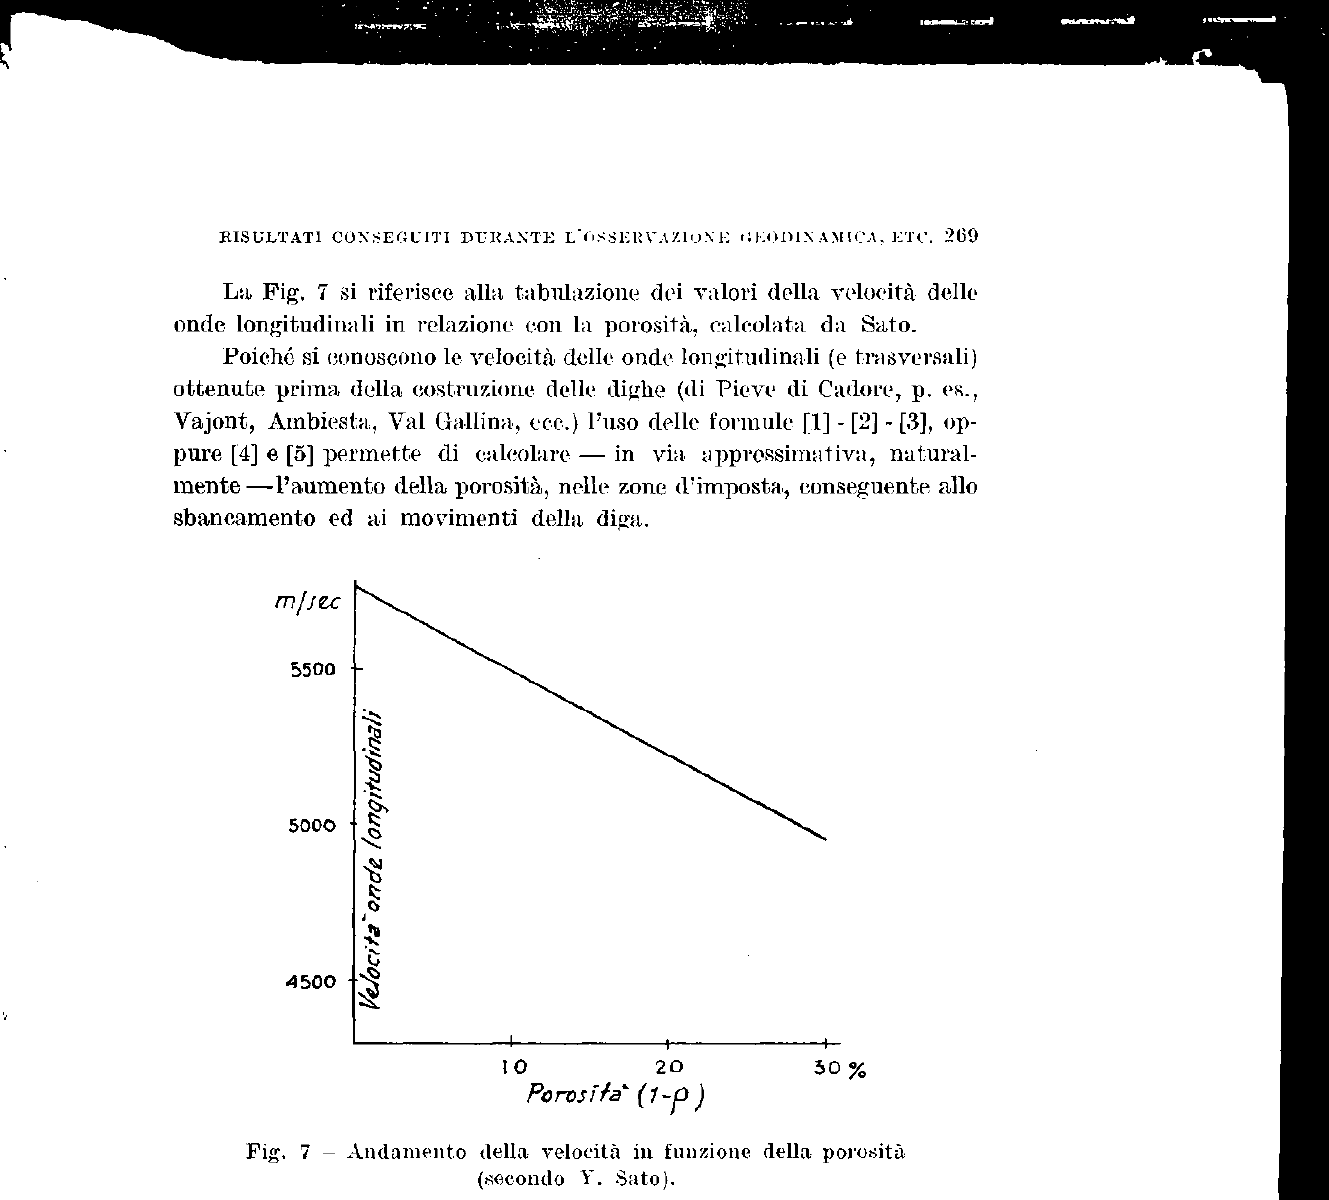
Fig. 7 - Andamento della velocità in funzione della porosità (secondo Y.